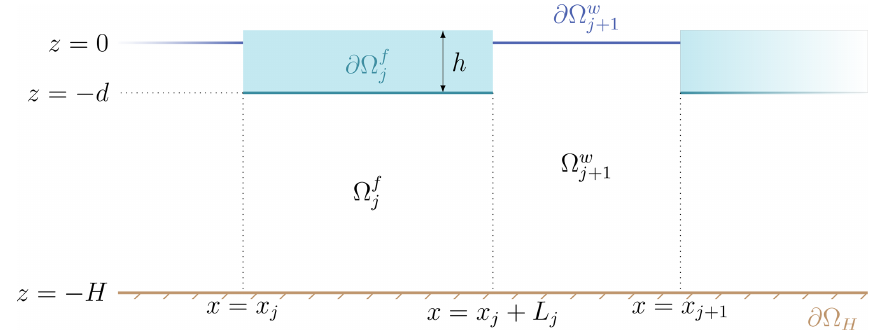
Figure 1. Geometry of the model at rest. Wave forcing would alter the fluid boundaries around z = 0 and z = − d